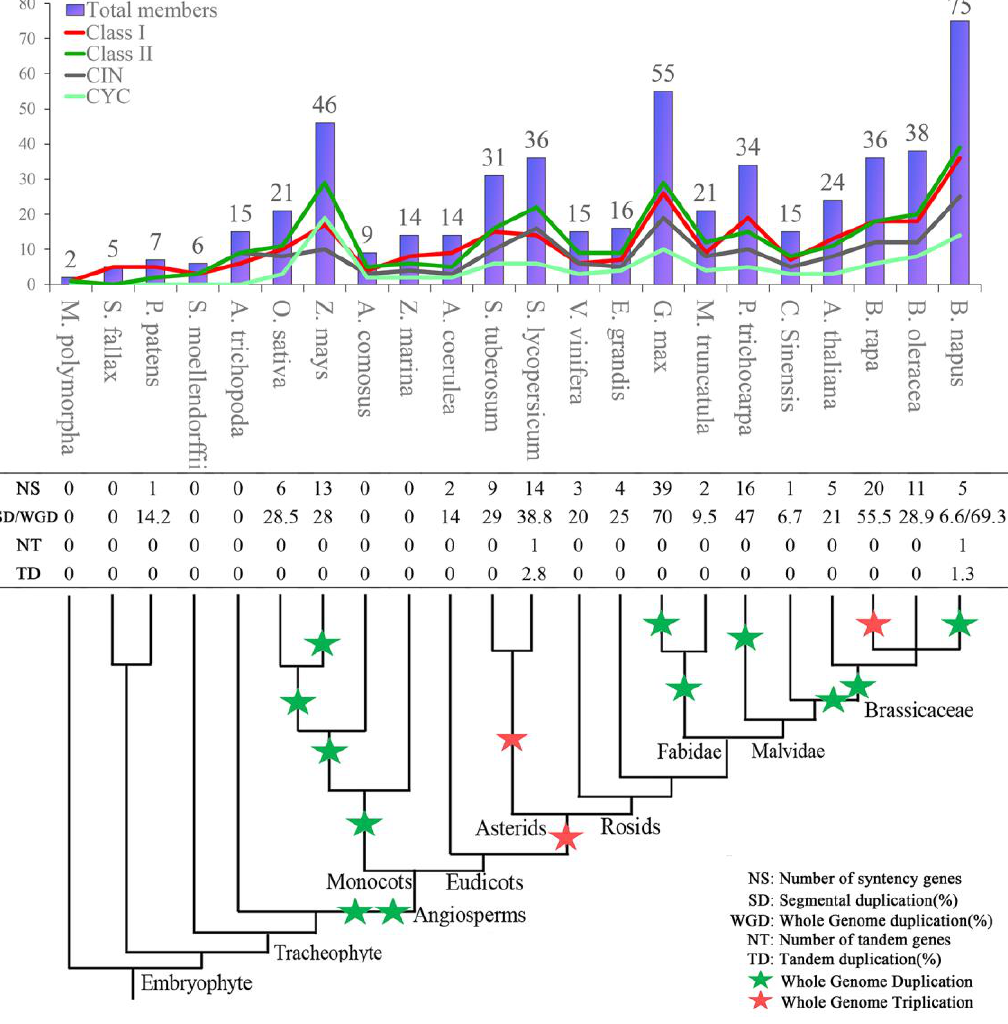
Figure 4. Number of duplications in land plant TCP genes. The histogram displays the number of TCP proteins in each species. Phylogenetic relationships among these species have been described in Phytozome [31]. Green and red stars indicate whole genome duplication and triplication in the corresponding species, respectively.